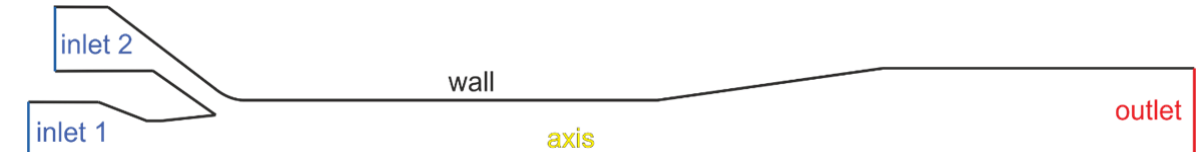
Table 1. Main geometry parameters of ejector.